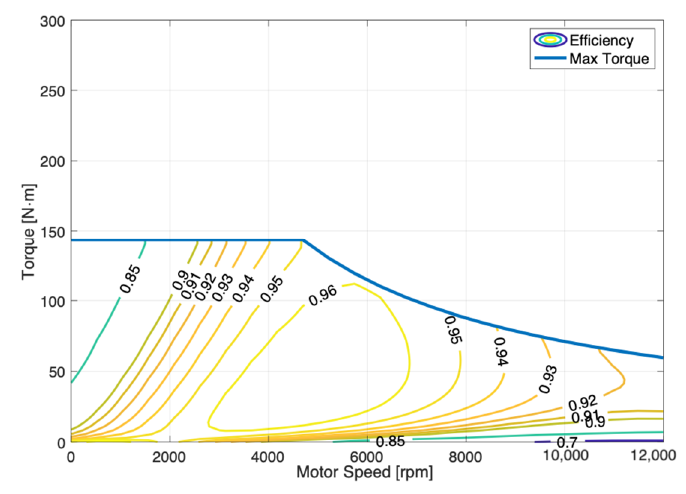
Figure 5. IDM e-motor efficiency map.